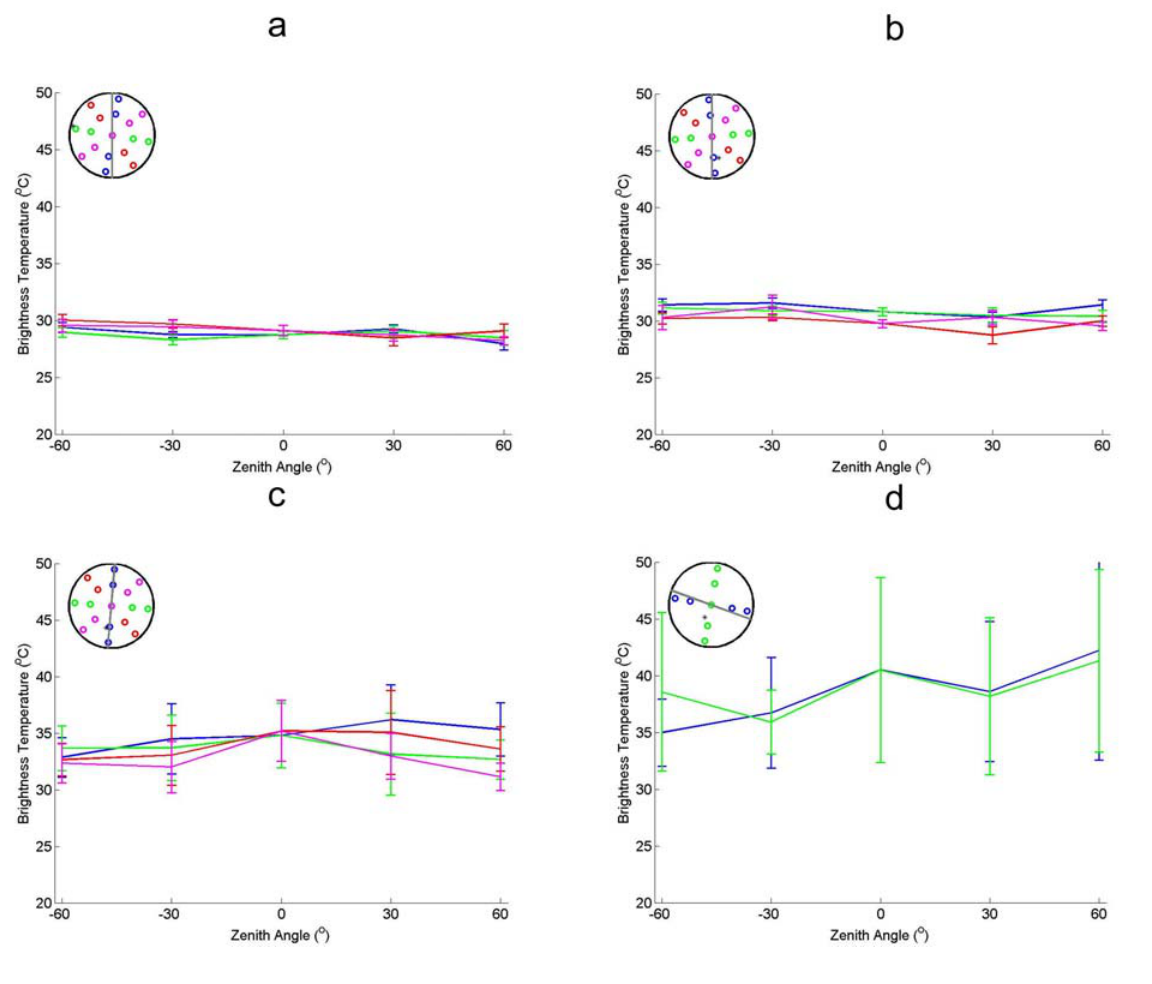
Figure 8. Thermal brightness temperatures obtained by Irisys thermal camera over different crops. (a) Figure A shows barley at 18:08 (AGRISAR) (b). B shows wheat at 11:30 (AGRISAR), (c) C shows sugar beet at 12:43 (AGRISAR) (d). D shows vineyard at 16:30 (SEN2FLEX). The error bars denote the standard deviation of the brightness temperatures in the image to the mean brightness